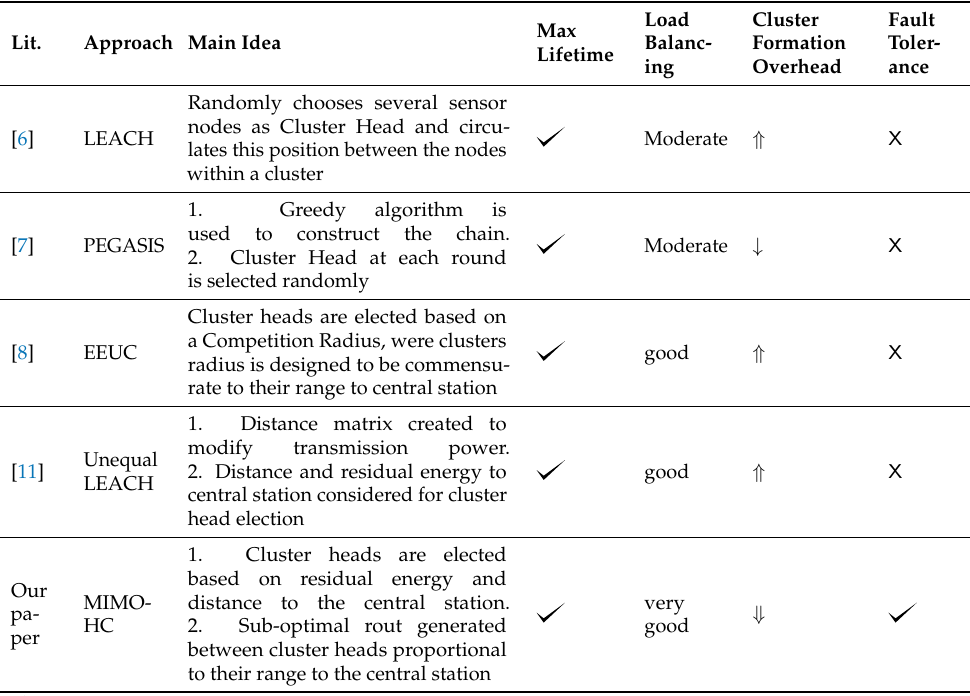
Table 1. Comparison of our proposed scheme with existing state-of-the-art literature interfaces.